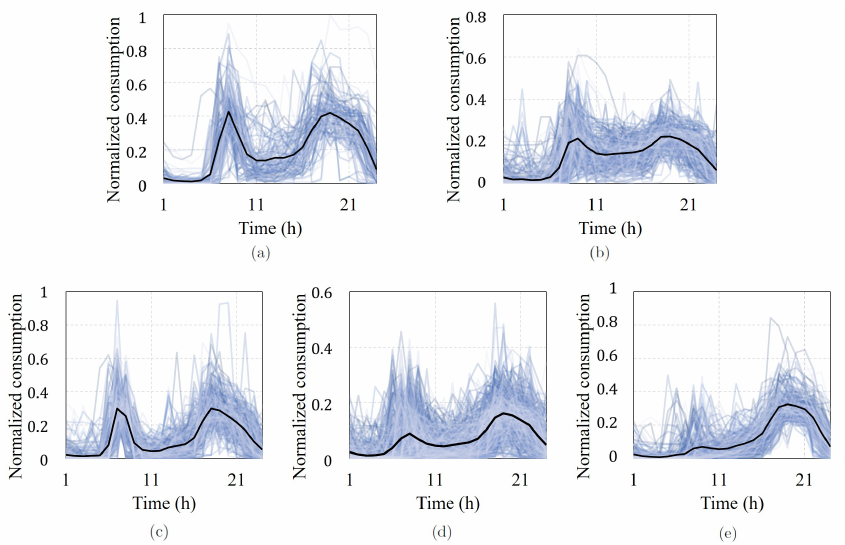
Figure 13. Winter profiles for five clusters using the KM algorithm: ( a ) Cluster 1; ( b ) Cluster 2; ( c ) Cluster 3; ( d ) Cluster 4; ( e ) Cluster 5.